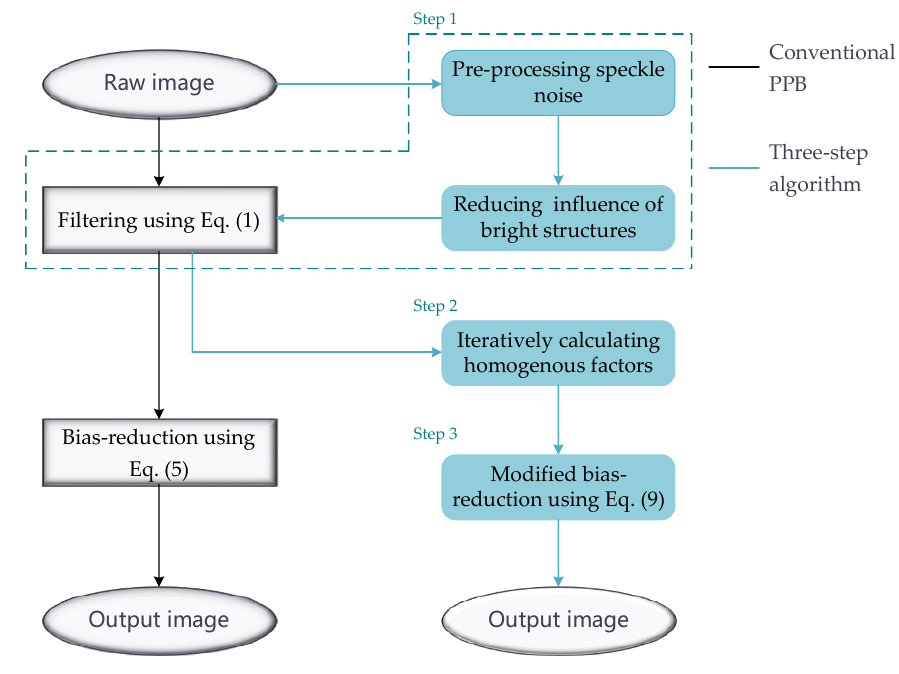
Figure 5. An illustration of the three-step algorithm.